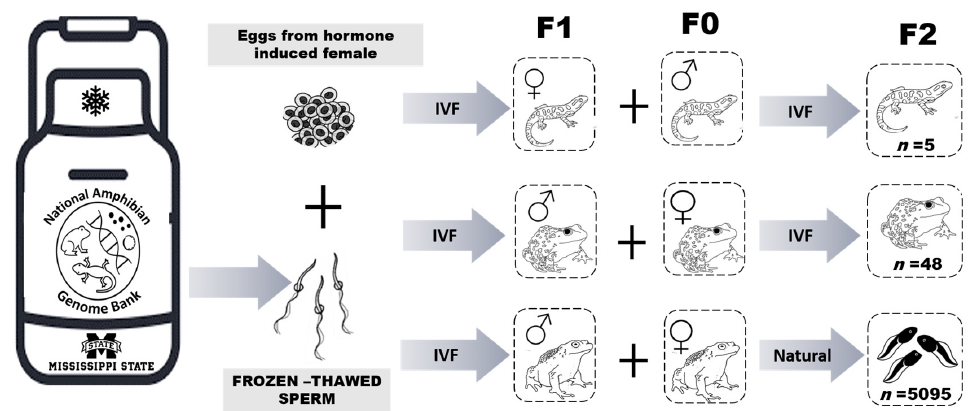
Figure 2. Schematic diagram of the Assisted Reproductive Technologies process used to create the F1 generation of adults and subsequent production of F2 progeny. IVF = in vitro fertilization and Natural = animals stimulated with hormones for natural breeding. F0 indicates animals not produced using cryopreserved sperm, F1 is the first generation produced using cryopreserved sperm, and F2 is the generation representing offspring from breeding the F1 and F0 animals.